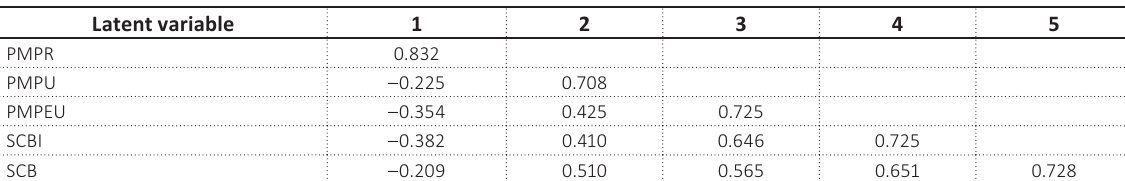
Table 6. Discriminant validity test